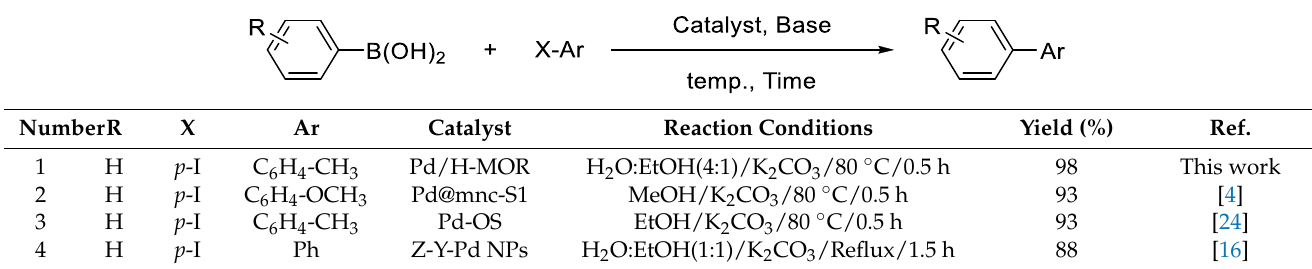
Table 2. Comparison of Pd/H-MOR with some recently reported Pd catalysts for the reaction of Suzuki coupling.